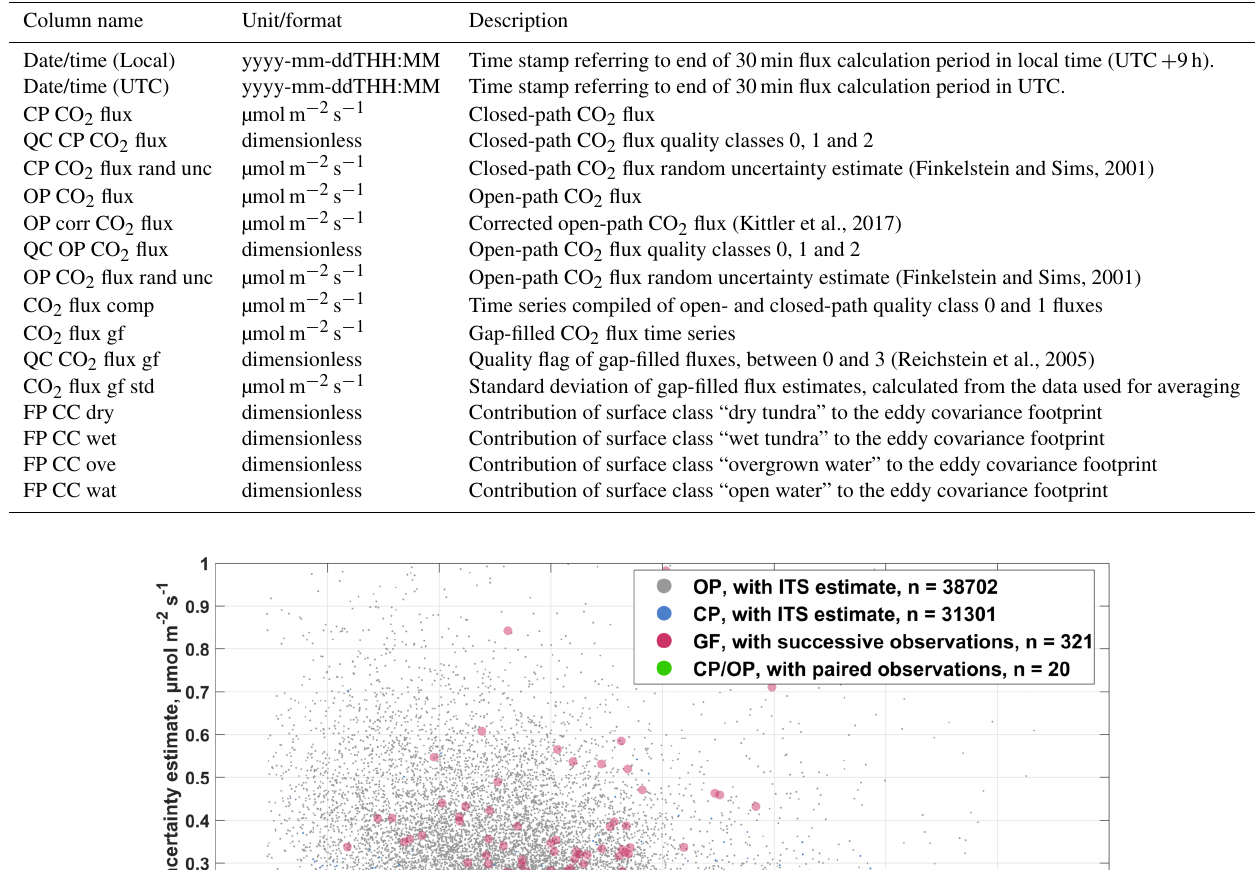
Table 7. Description of columns included in the data set file.